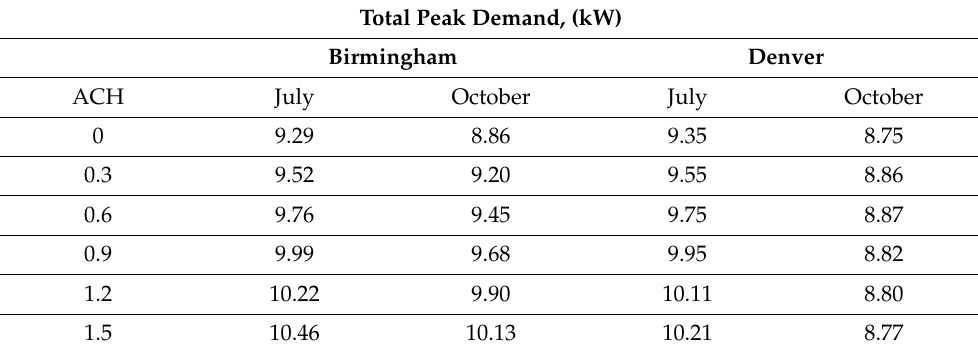
Table 10. Total household peak demand for varying air infiltration rates.